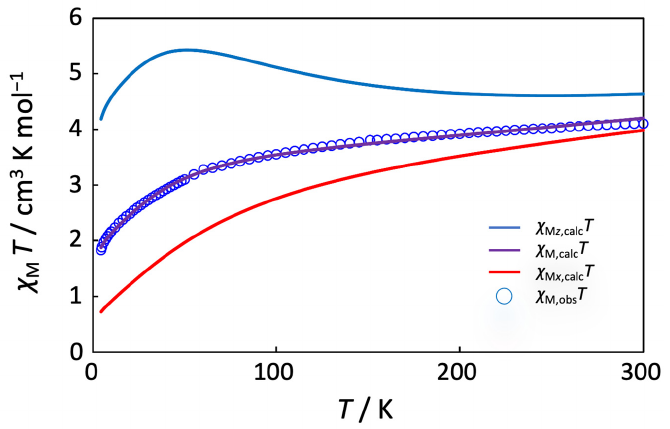
Figure 7. Variable temperature of χ M T for [Co 3 (Hclsalpr) 2 (CH 3 COO) 4 ] (blue circle). The solid lines were calculated and drawn with the parameter values described in the text.